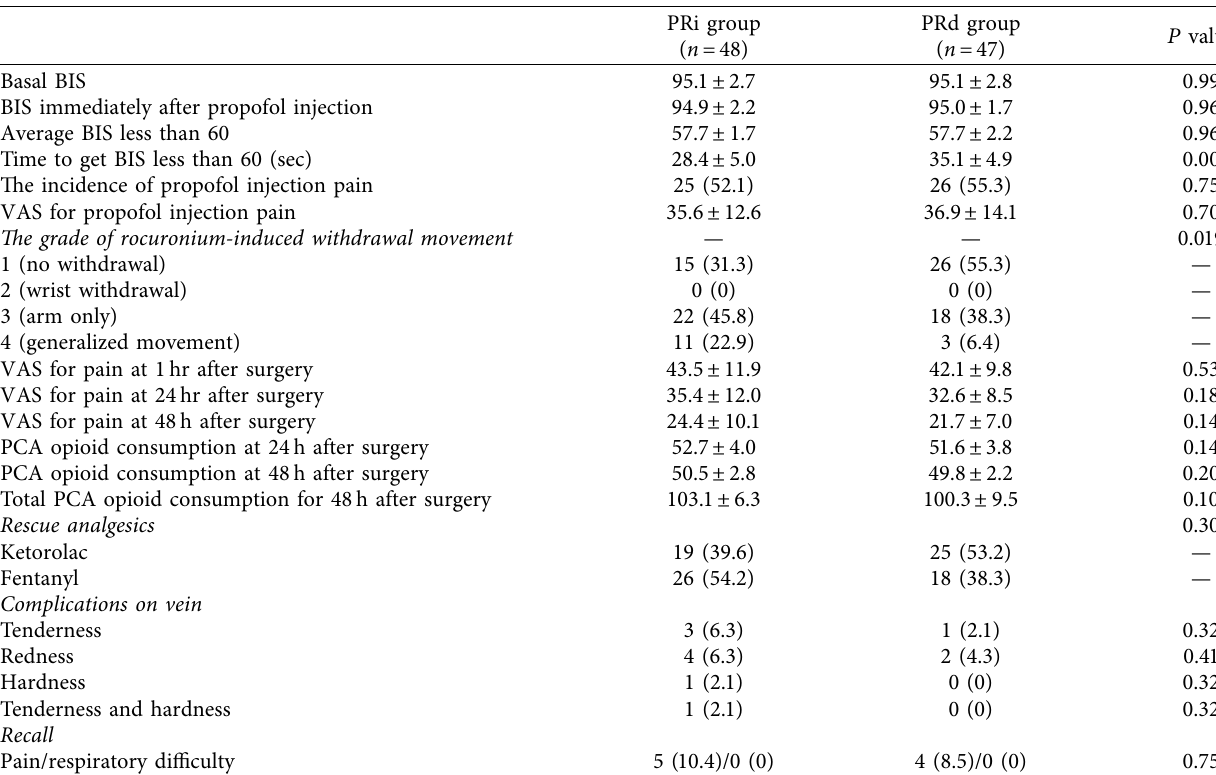
Table 2: Perioperative data.